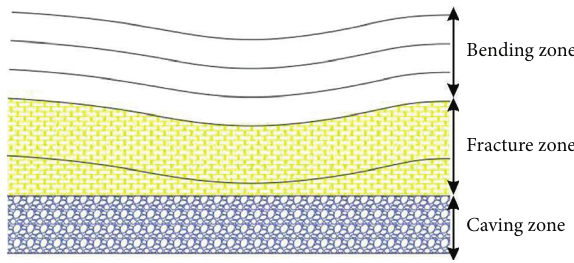
Figure 12: Overlying strata movement zones in a